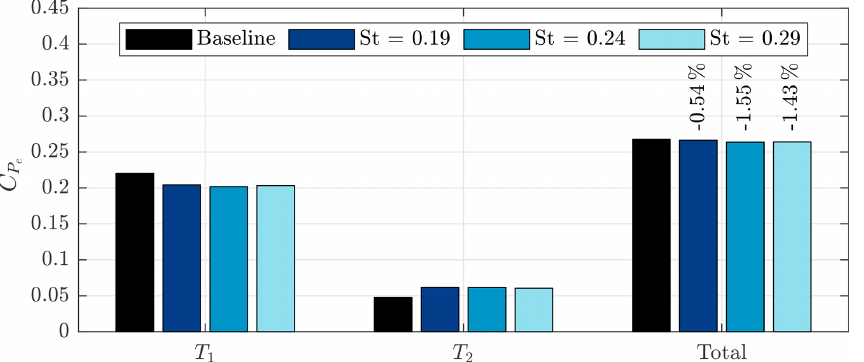
comparing baseline control with DIC for three different frequencies. The first column shows the Figure 12. Average power coefficient C P e power of the measurement turbine, the second column shows the power of a hypothetical turbine located at a distance of x/D = 3 in the wake, and the final column shows the combined power of T 1 and T 2 . Table 1. Comparison of wake properties for a hypothetical turbine at x/D = 3 downstream with DIC compared to baseline operation. The different columns indicate values of the Strouhal number St , average thrust coefficient C T , thrust amplitude (cid:49)C T , average induction factor a , fraction of AP based on actuator disk theory f AD , and fraction of AP based on the PIV measurements f PIV . AP AP f PIV Control strategy St C T (cid:49)C T a U AD w f AD AP AP Baseline – 0.58 – 0.18 2.57 0.27 0.20 DIC 0.19 0.57 0.13 0.17 2.60 0.28 0.26 0.24 0.56